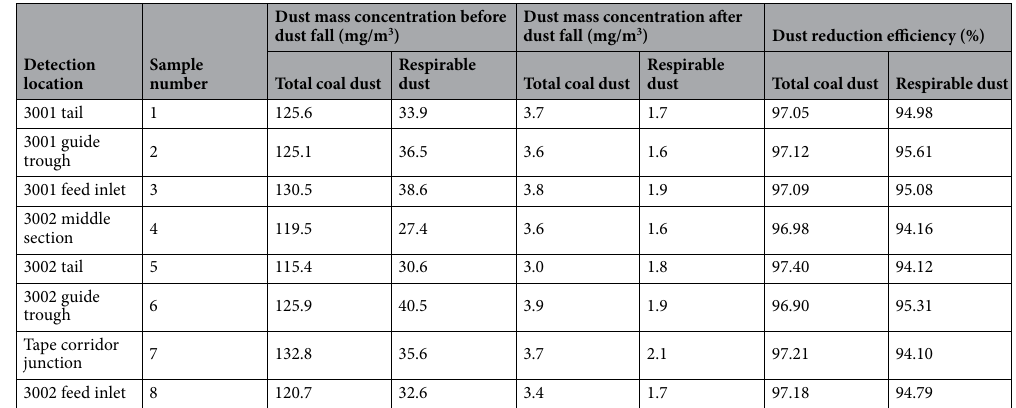
Table 2. Dust concentration and dust reduction efficiency.